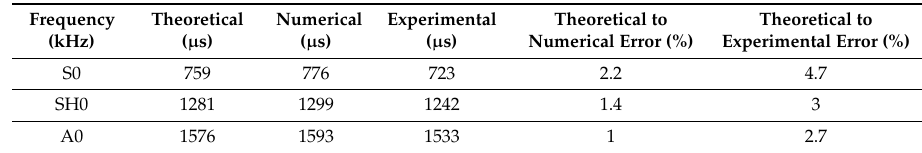
Table 4. Comparison of theoretical, numerical, and experimental ToA of modes of interest (P.1—direct path). Frequency